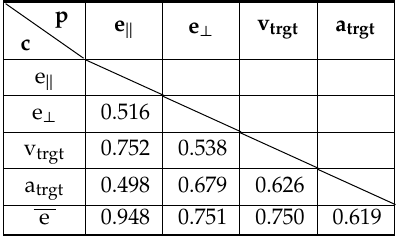
Table 2. Pearson correlation coe ffi cients among average properties of movement over all tasks. Below the diagonal are the Pearson’s cross correlation coe ffi cients. In all cases, the coe ffi cients are statistically significant with p far smaller than 0.0001. c